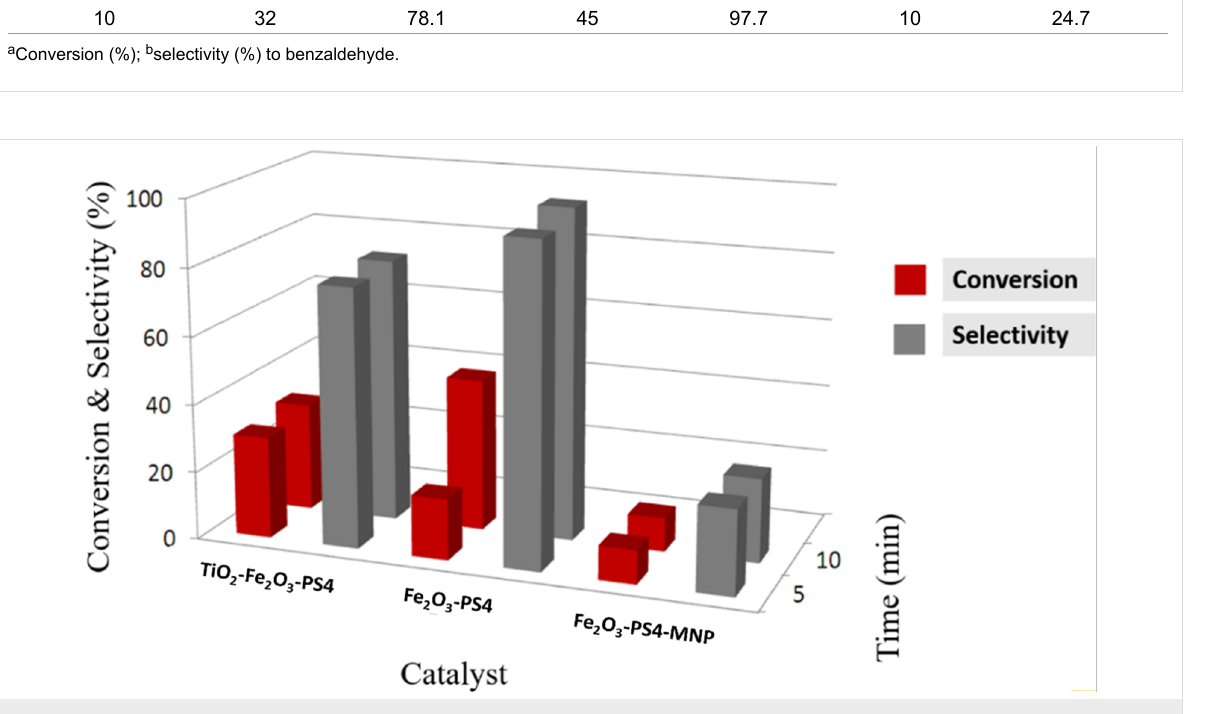
Figure 5: Conversion and selectivity of the oxidation of benzyl alcohol for the three catalytic systems.